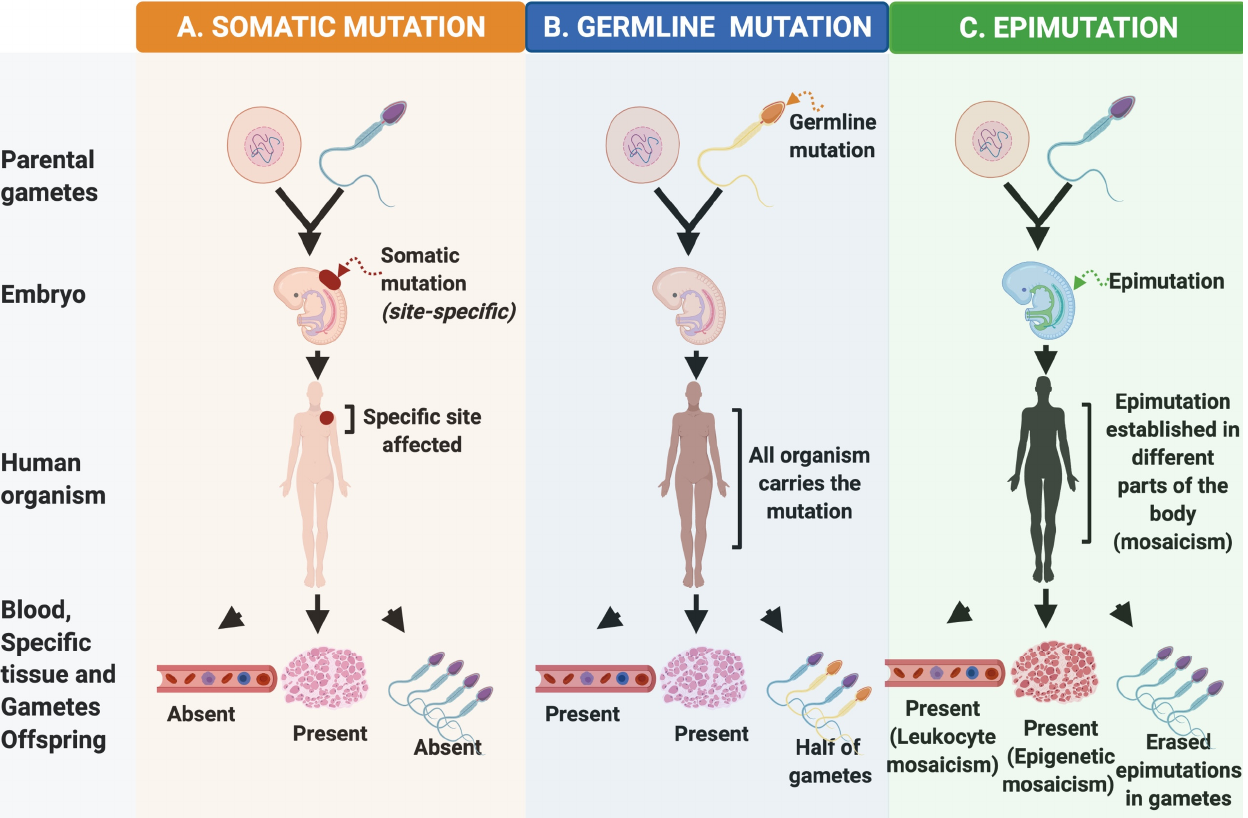
Figure 2 . Early alterations during human carcinogenic development. Three important events for early carcinogenic development are described: ( A ) somatic mutations, ( B ) germline mutations, and ( C ) epimutations; focused on the different stages from the parental gametes, embryonic, in the human body, and within the latter detected as the presence or absence of the alteration in blood, specific tissue, and descendant gametes.